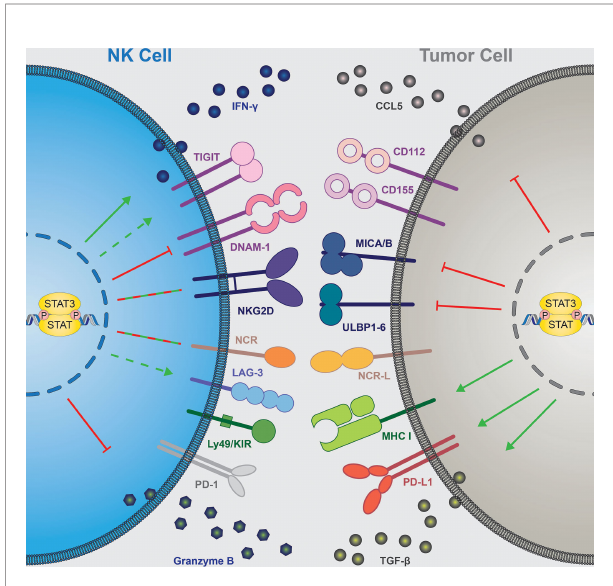
FIGURE 2 | STAT3 contribution to NK cell-mediated tumor immune surveillance. NK cell-intrinsic STAT3 ( left ) inhibits expression of granzyme B and DNAM-1 ( ) , increases IFN g secretion ( ) and seems to upregulate TIGIT and LAG-3 ( ), while the effect on NCRs and NKG2D expression remain context dependent ( ) . Tumor cell-intrinsic STAT3 ( right ) inhibits expression of NKG2D ligands (MICA/B, ULBPs) and NK-cell attracting chemokine CCL5 ( ). STAT3 in tumor cells upregulates surface expression of MHC I and PD-L1 molecules and secretion of immune suppressive TGF- b ( ). NK, natural killer; IFN, interferon; DNAM-1, DNAX accessory molecule; NKG2D, NK-cell receptor natural killer group 2D; NCR, natural cytotoxicity receptor; KIR, killer-cell immunoglobulin-like receptor; CCL5, C-C motif chemokine ligand 5; CD, cluster of differentiation; MICA/B, major histocompatibility complex class I-related sequence A/B; ULBP, UL16-binding protein; MHC I, major histocompatibility complex I; TGF- b , transforming growth factor b , STAT, signal transducer and activator of transcription. TIGIT, T cell immunoreceptor with Ig and ITIM domains; LAG-3, lymphocyte- activation gene 3; PD-(L)1, programmed cell death ligand/protein